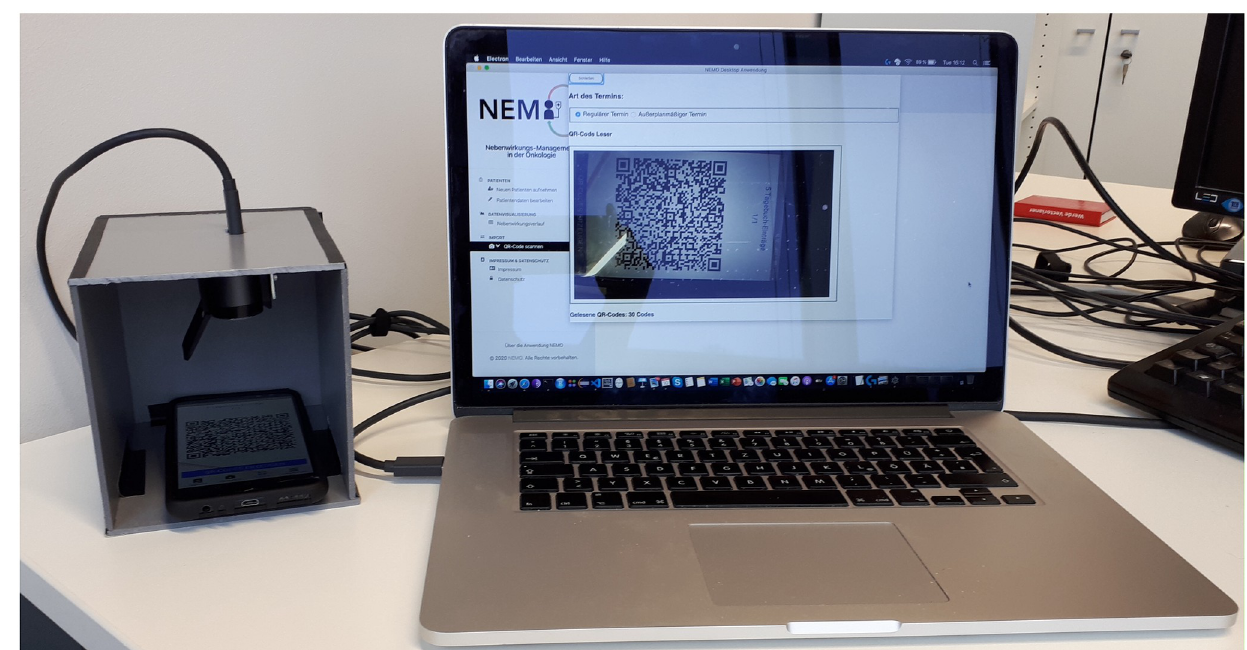
Fig 4. Secure data transfer. If a patient is willing to transfer its data, a QR code can be generated on the mobile phone (a) that allows secure data transfer via scanning (b). Example of the data transfer from the mobile phone to the desktop computer (image copyright Institute of Medical Systems Biology, Ulm